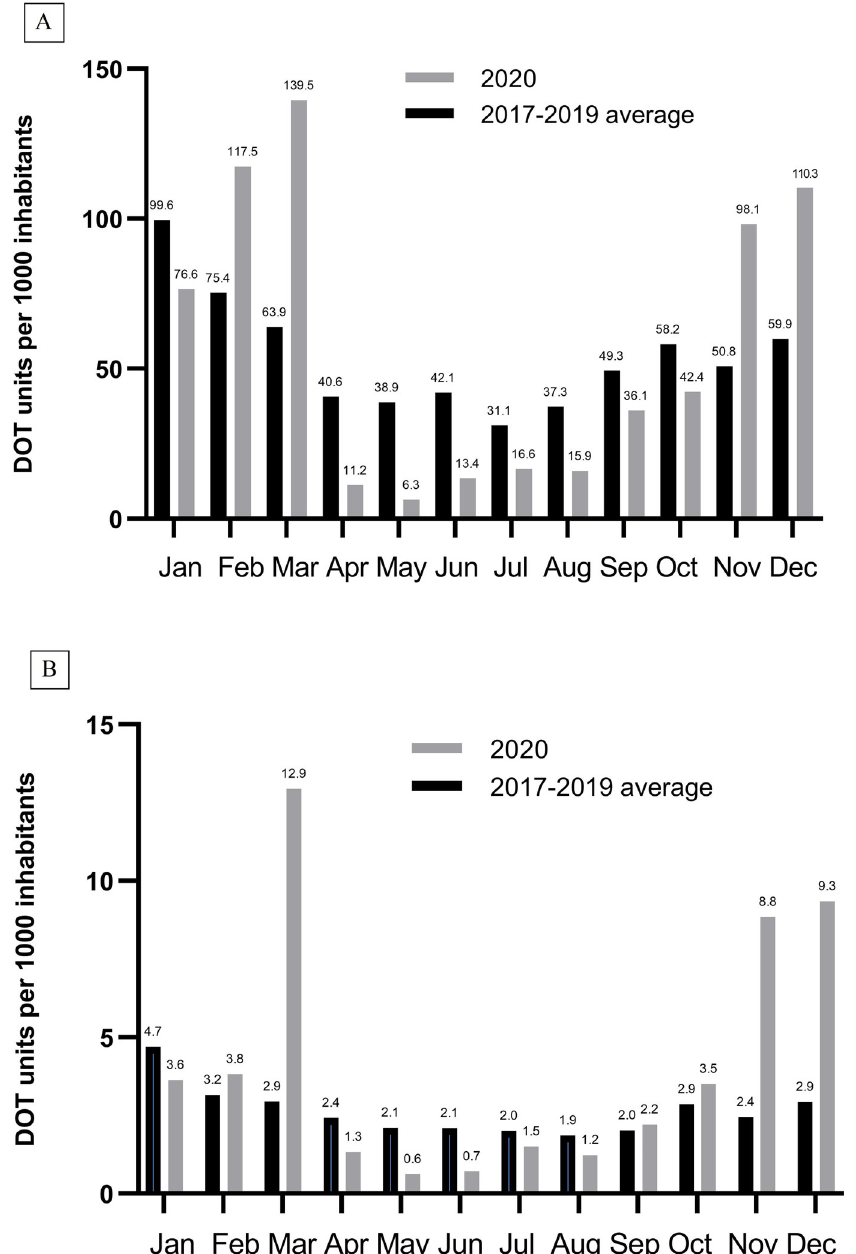
Fig 2. The monthly distribution of azithromycin in 2020 compared to the average of 2017 to 2019 for non-hospital (panel A) and hospital (panel B) pharmacies in Croatia. DOT, days of therapy.